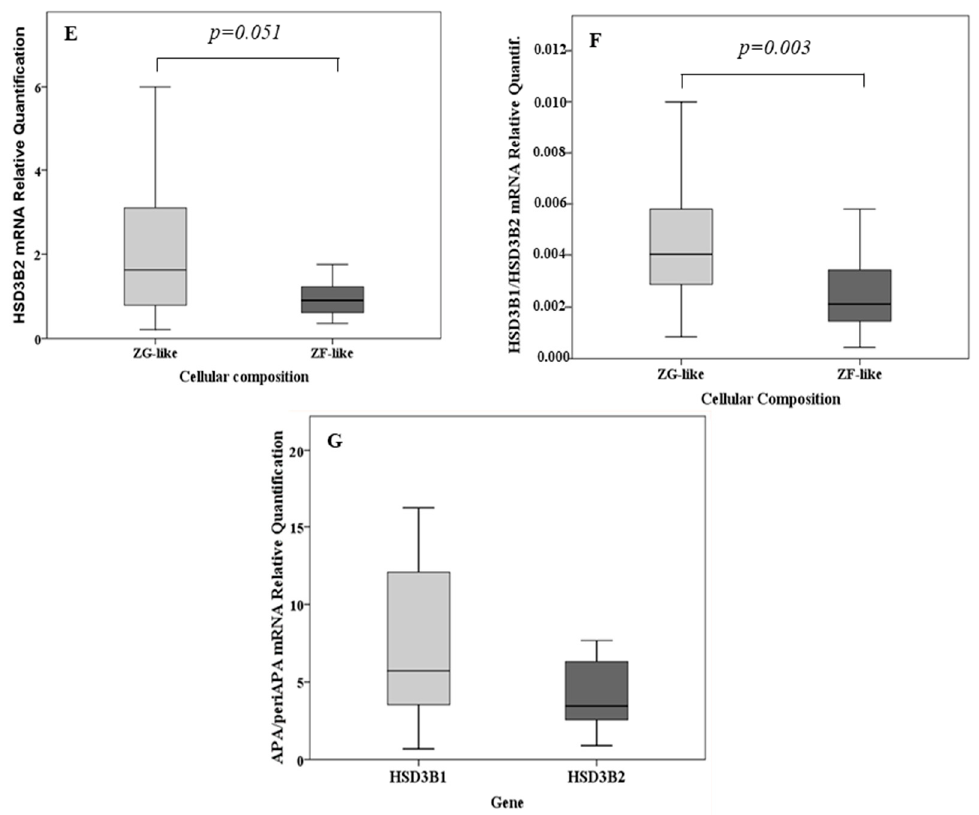
Figure 1. ( A ) Relative quantification of cryptochrome-1 ( CRY1 ) mRNA over cryptochrome-2 ( CRY2 ) messenger RNA (mRNA) in the total cohort, in aldosterone-producing adenoma (APA) samples ( n = 35) and in unilateral adrenal hyperplasia (UAH) samples ( n = 11). ( B ) Relative quantification of CRY1 and CRY2 mRNA in APA samples over that in the corresponding adjacent adrenal cortex ( n = 20). ( C ) Relative quantification of type II 3 β -hydroxyl-steroid dehydrogenase ( HSD3B2 ) mRNA over type I 3 β -hydroxyl-steroid dehydrogenase ( HSD3B1 ) mRNA in the total cohort, in APA samples ( n = 35) and in UAH samples ( n = 11). ( D ) HSD3B1 mRNA expression according to the cellular composition in the total cohort of adrenal samples. ( E ) HSD3B2 mRNA expression according to the cellular composition in the total cohort of adrenal samples. ( F ) Relative quantification of HSD3B1 mRNA over HSD3B2 mRNA according to the cellular composition. ( G ) Relative quantification of HSD3B1 and HSD3B2 mRNA in APA samples over that in the corresponding adjacent adrenal cortex. For each box plot, the horizontal line represents the median, and the box and bar indicate the 25th to 75th and 5th to 95th percentiles,